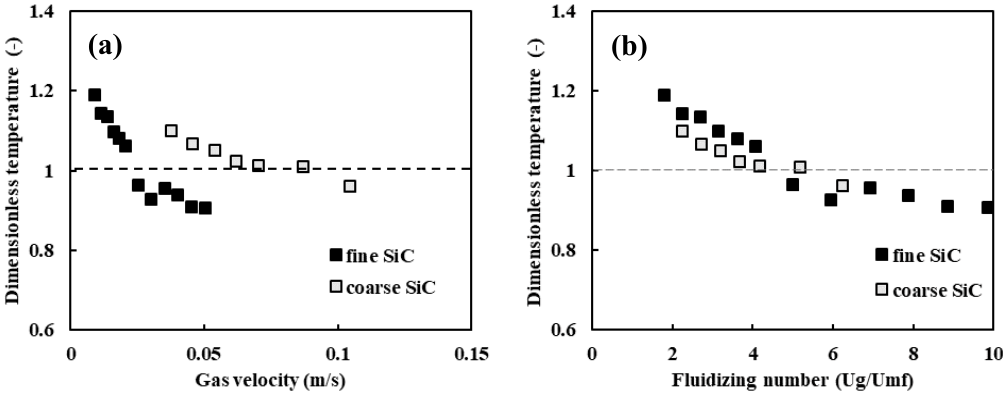
Figure 5. Effects t of (a) gas velocity and (b) fluidizing number on dimensionless temperature (T*). Figure 5. E ff ects t of ( a ) gas velocity and ( b ) fluidizing number on dimensionless temperature